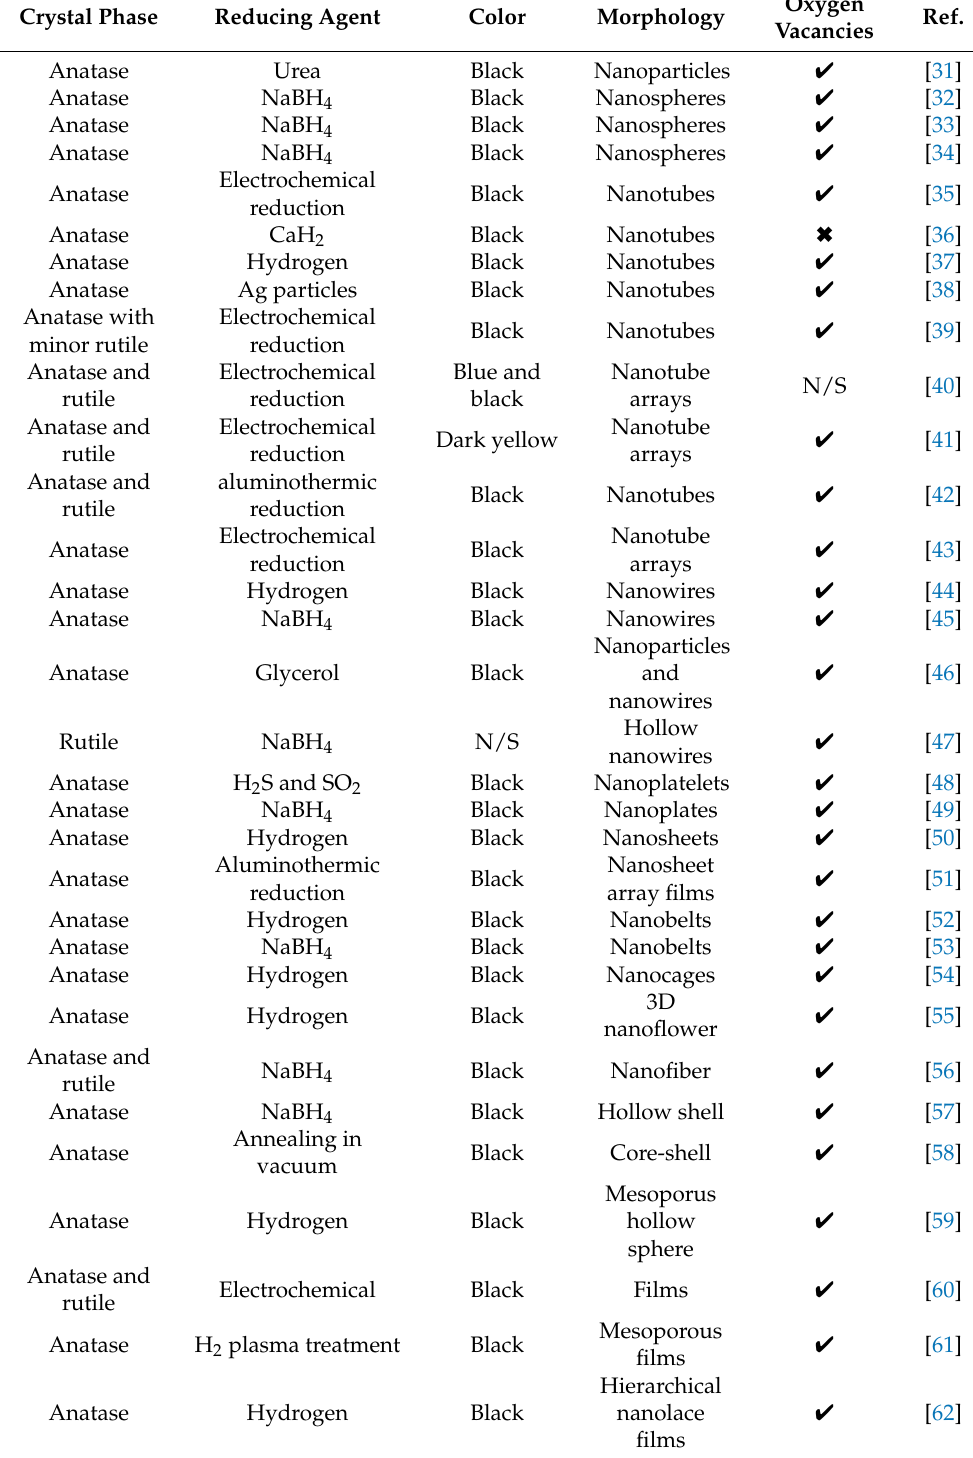
Table 1. Cont. Crystal